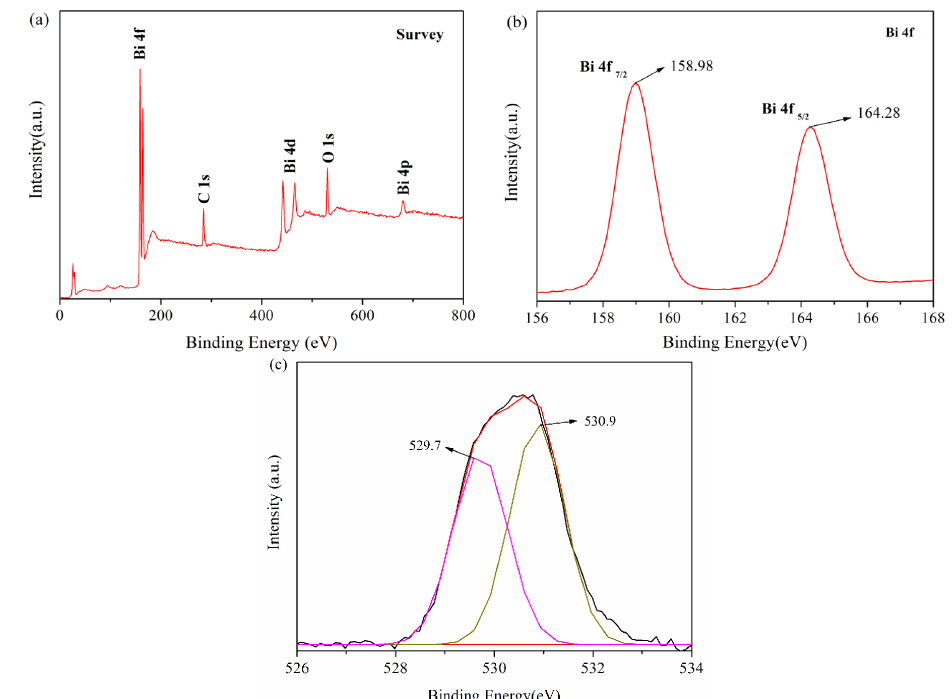
Figure 5. ( a ) XPS spectrum of BC ‐ 873 ‐ 5; High ‐ resolution XPS spectra of ( b ) Bi 4 f and ( c ) O 1 s in BC ‐ 873 ‐ 5.